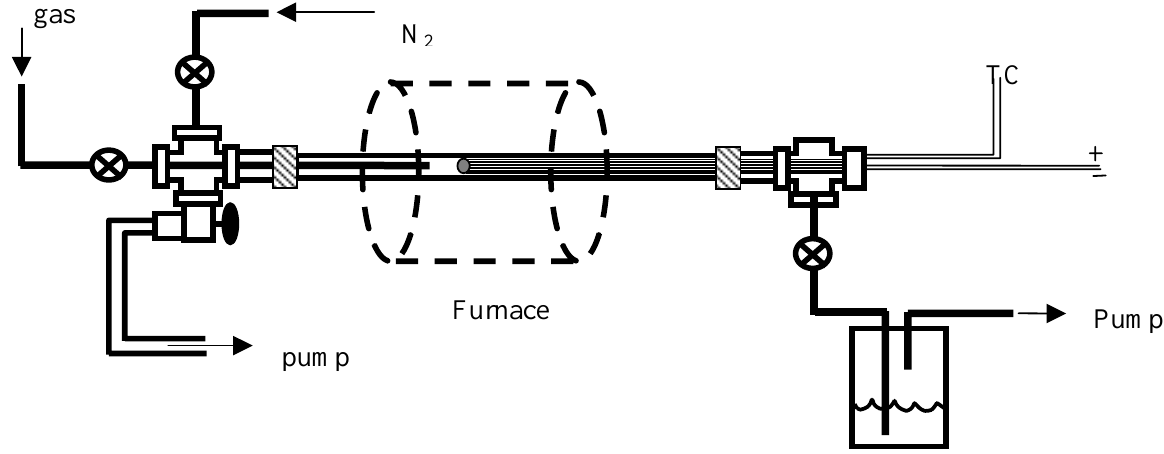
Figure 3. Schematic of environmental test chamber into which different gases can be introduced and the GaN-based sensors tested at different temperatures under different gas